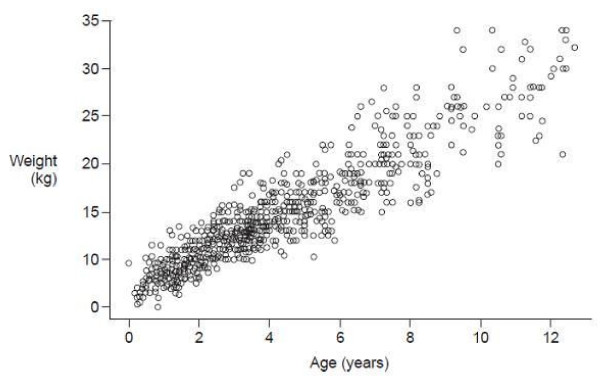
Scatter plot of weight at baseline visit according to age (safety population).